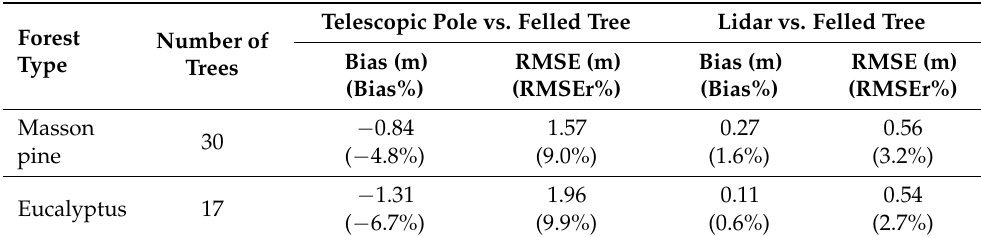
Table 4. Evaluation of measured tree heights using different methods. Telescopic Pole vs. Felled Tree Lidar vs. Felled Forest Number of Type Trees